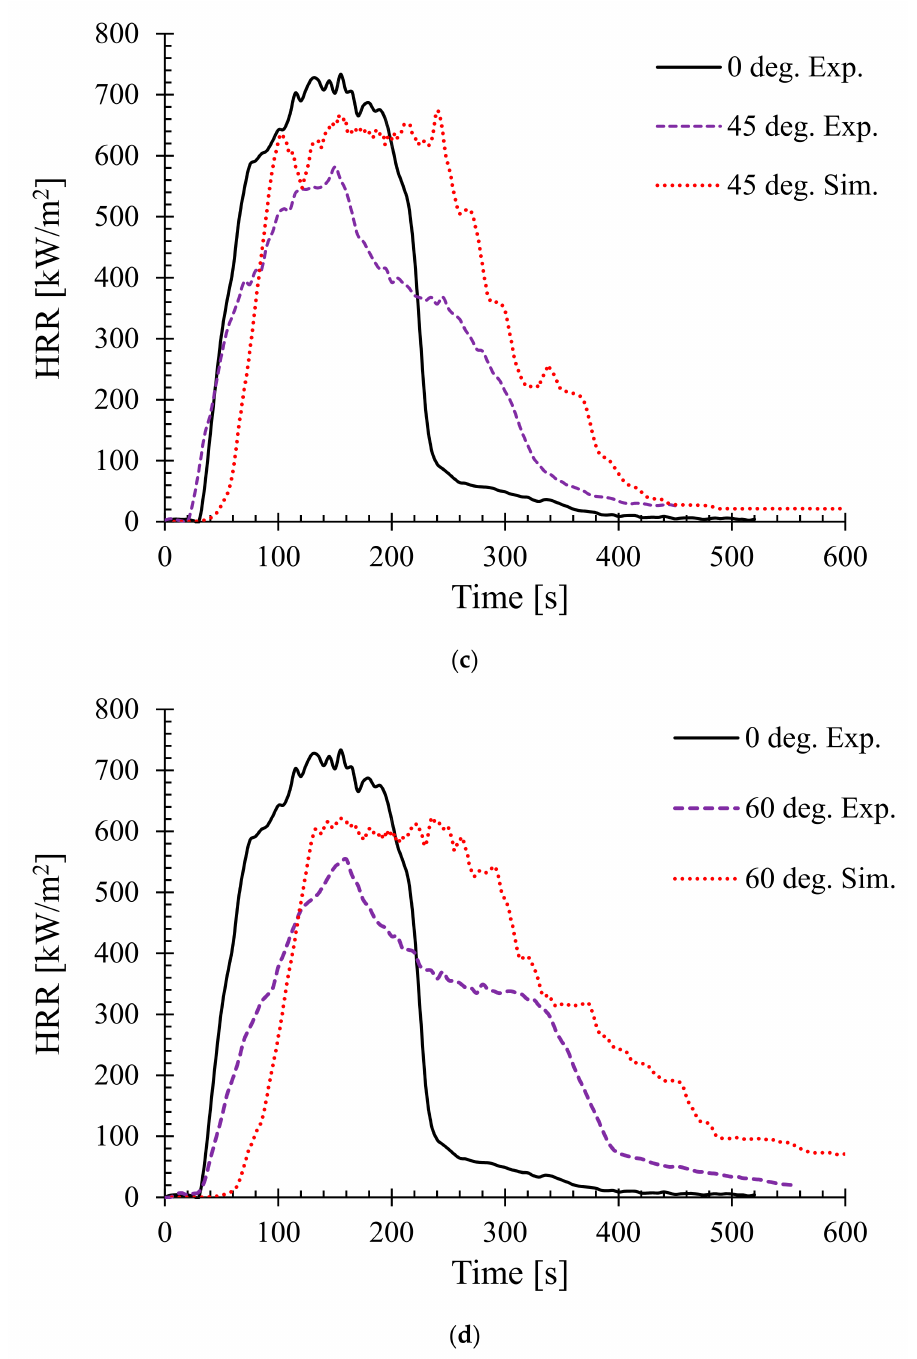
Figure 7. Heat release rates (HRR) for samples oriented at different angles at 50 kW/m 2 —( a ) 15 ◦ , ( b ) 30 ◦ , ( c ) 45 ◦ , and ( d ) 60 ◦